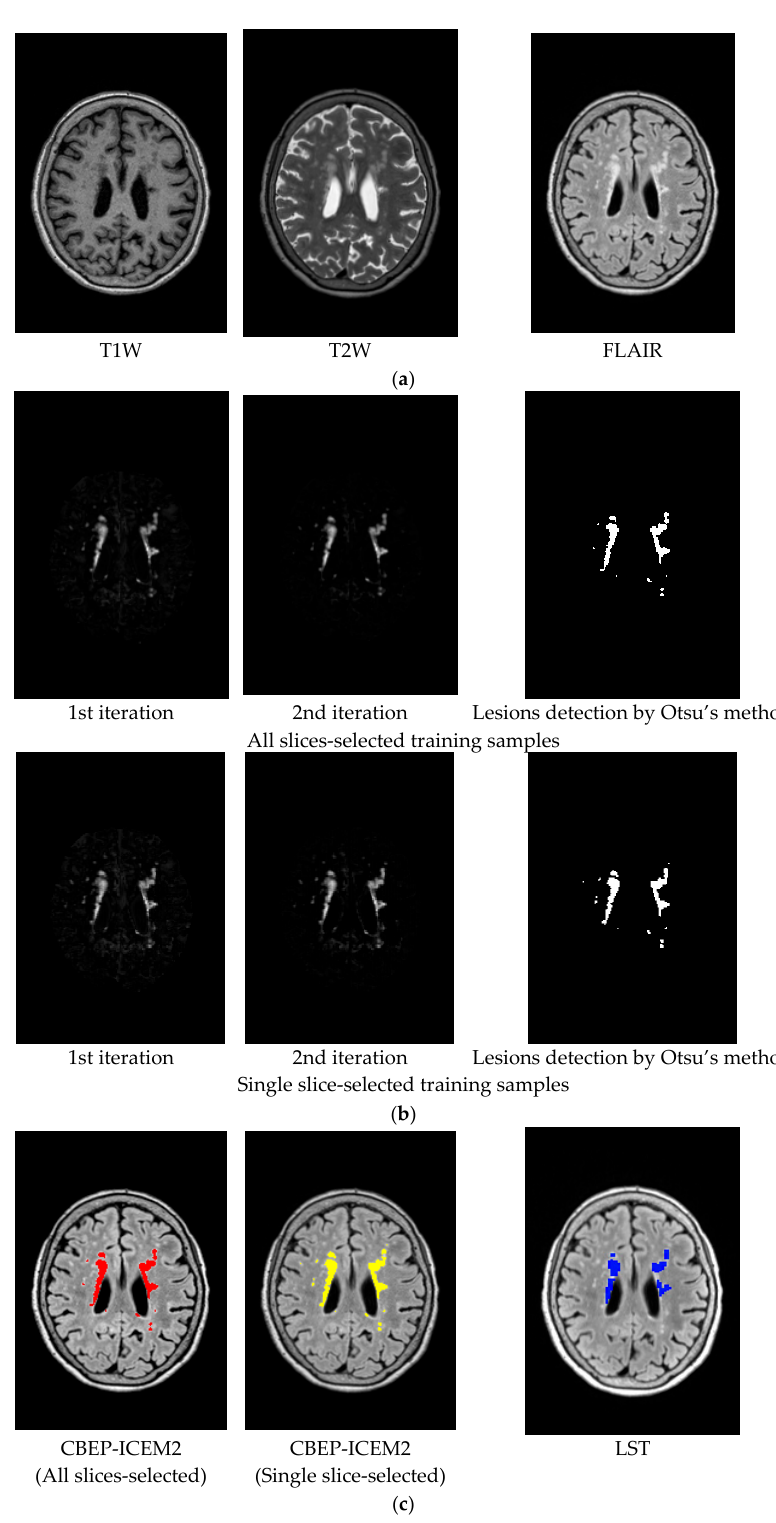
Figure 13. Lesion detection of Fazekas grade 2 By CBEP-ICEM2 and LST. ( a ) Original MR images (T1W, T2W, FLAIR) with lesions of Fazekas grade 2; ( b ) Lesion detection by CBEP-ICEM2; ( c ) Comparison between lesion detections by CBEP-ICEM2 and LST.